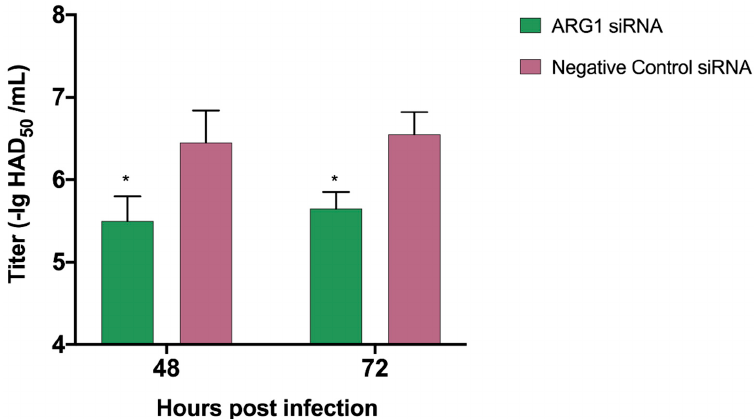
Figure 11. The influence of knockdown of ARG 1 gene on ASFV replication. The siRNA targeting the ARG1 gene with the highest knockout efficiency was transfected into PAM cells. Three days post transfection, PAM cells were infected with ASFV, and the cell culture supernatant was har- vested 48 h and 72 h post-infection. The HAD50 method was used to detect the ASFV virus titer. The p values were calculated, * p < 0.05.